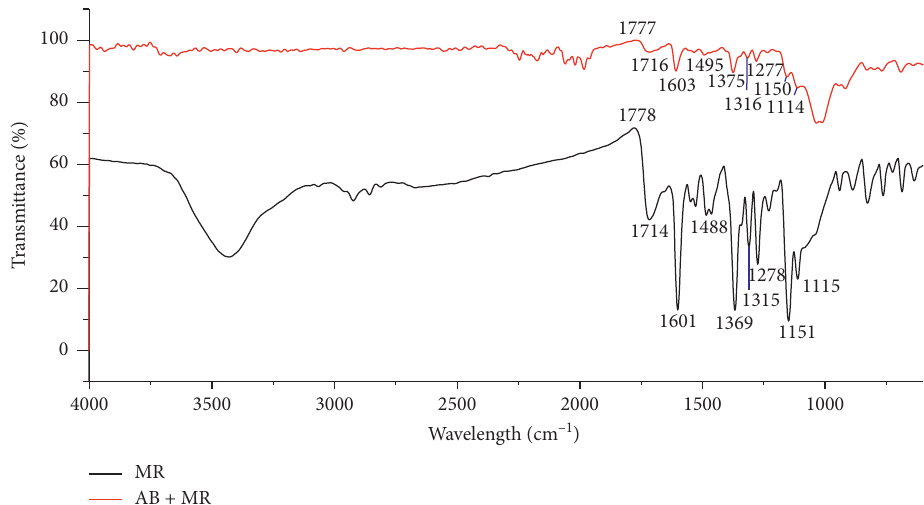
Figure 8: FTIR spectra of methyl red (MR) dye and after its adsorption by purified clay (MR+ANp).